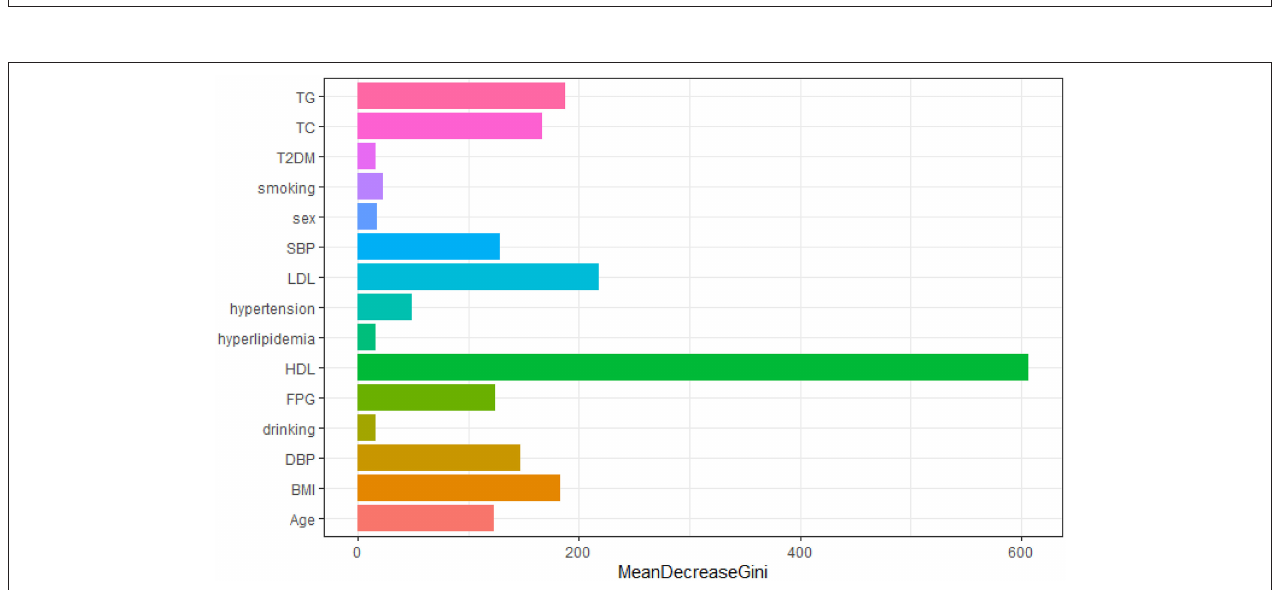
FIGURE 4 | Variable importance plot for the Random Forest model. The x -axis is the average decrease in the Gini coefficient, the y -axis is 15 risk factors of CAD. The more the average decrease of the Gini coefficient, the more important of the variable.